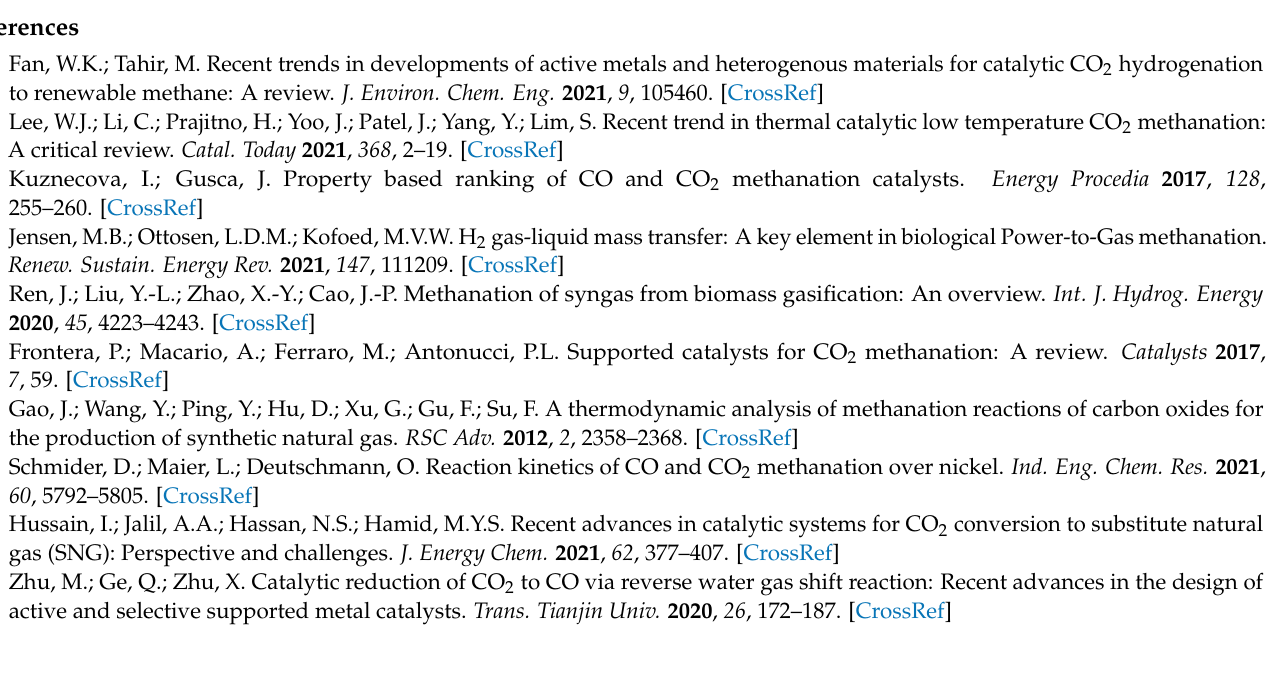
Table S1: Characterization of organometallic precursor of nickel-alumina catalyst, Figure S2: XRD pattern of hexakis-(imidazole) nickel (II) nitrate complex prepared by solvent-free dry-melt synthesis, Figure S3: FTIR spectra of gases released during heating of (a) Ni-Al 2 O 3 -SSC and (b) NIAP-07- 01 catalysts (argon, 10 ◦ C min − 1 ),Table S2: Surface composition of the nickel-alumina catalysts as determined by XPS analysis, Figure S4: Survey XPS spectra of NIAP-07-01 and Ni-Al 2 O 3 -SSC catalysts, Figure S5: Low-temperature nitrogen adsorption/desorption isotherms for (a) NIAP-07-01 and (b) Ni-Al 2 O 3 -SSC catalysts, Figure S6: Effect of temperature on composition of gas at the reactor outlet during CO 2 methanation over Ni-Al 2 O 3 -SSC and NIAP-07-01